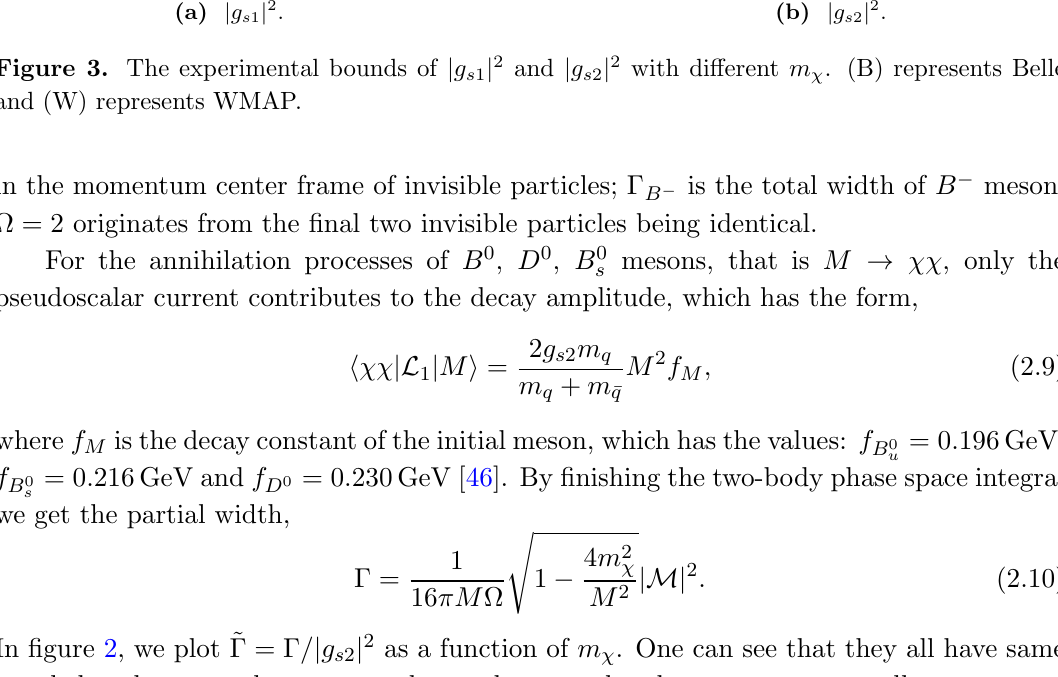
(cid:31) . (B) represents Belle